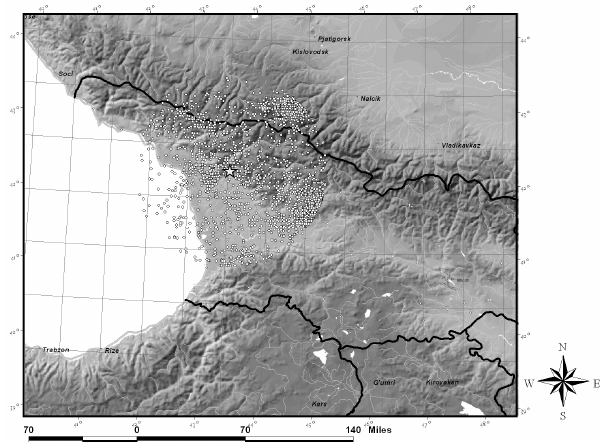
Fig. 1. Earthquake distribution in 100km area around Enguri high arch dam.